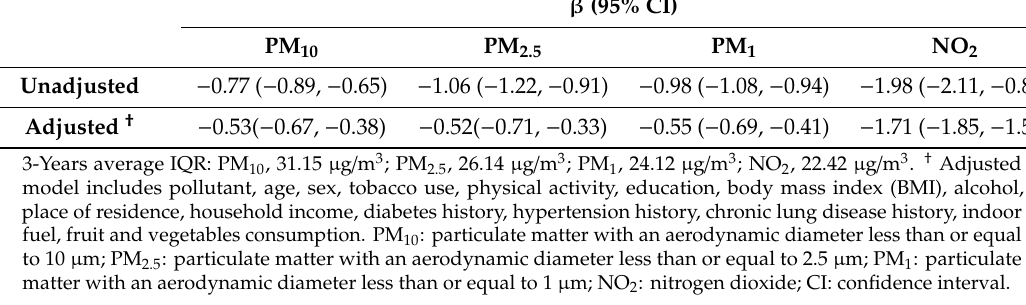
Table 4. Association between haemoglobin levels g / dL and 3-year moving averages of pollutant. β (95% CI) PM 10 PM 2.5 PM 1 NO 2 Unadjusted − 0.77 ( − 0.89, − 0.65)